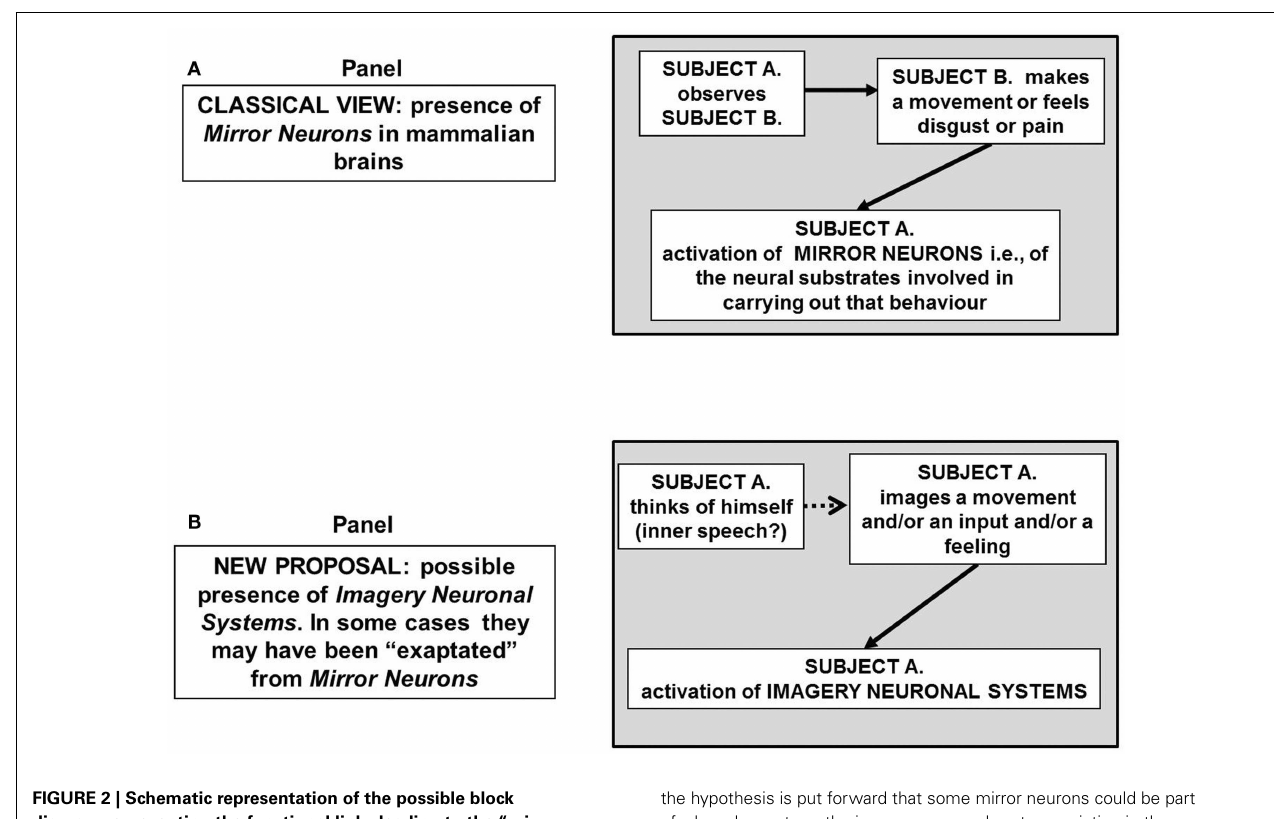
FIGURE 2 | Schematic representation of the possible block diagram representing the functional links leading to the “mirror neurons” that is of neurons that neuron “mirror” the behavior of activated motor neurons even if the observer is not really acting (A) hence mirror neurons sub serve two different functions . In (B)